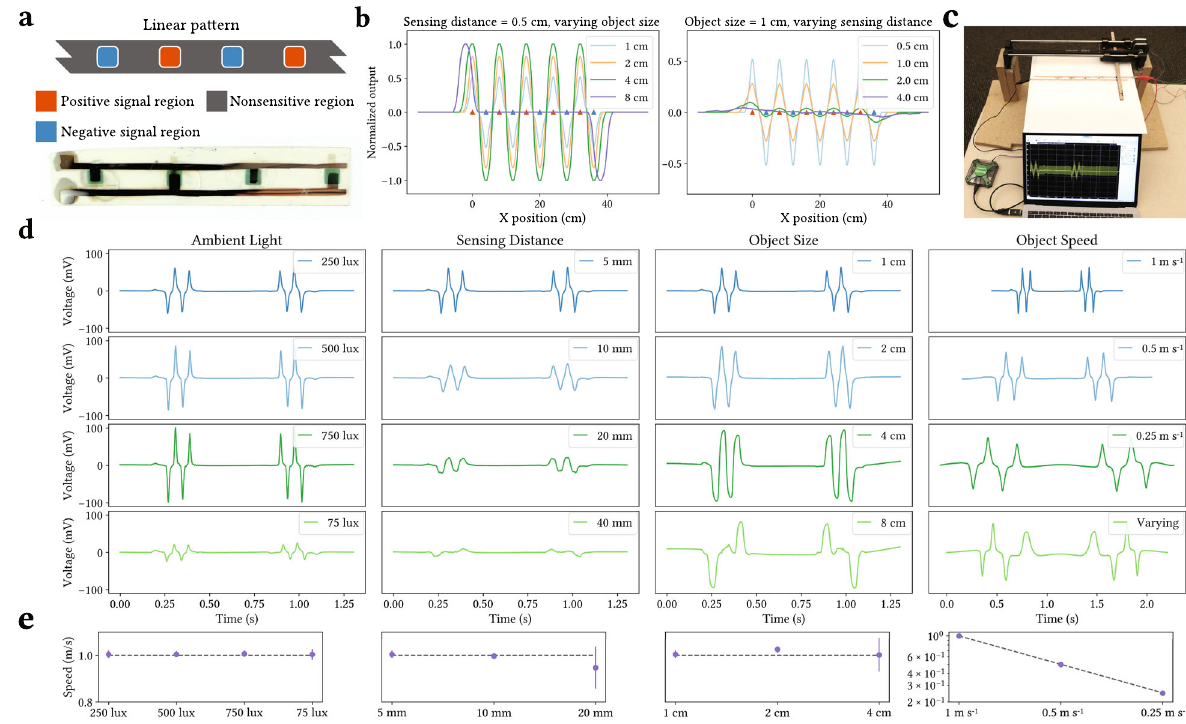
Fig. 3 Linear pattern. a Design and prototype of a computational photodetector with a linear pattern. b Simulation of responses from a linear pattern with alternating-polarity photodiodes and an interspace of 4 cm when an object hovers over with varying object sizes or sensing distances. c Experiment setup of technical evaluation using a linear actuator and laser-cut wooden bars with variable widths for light blocking. d Sensor output in various conditions of ambient light, sensing distance, object size, and object speed. e Speed detection result for the above conditions.